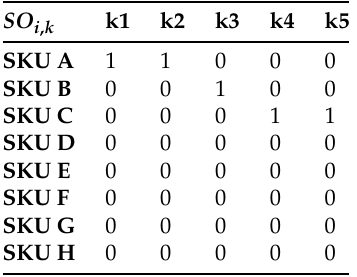
Figure 1. Bill of materials example representation in the Generic Materials and Operational Planning (GMOP) model [28]. Table 1. Stroke outputs matrix, according to Figure 1.